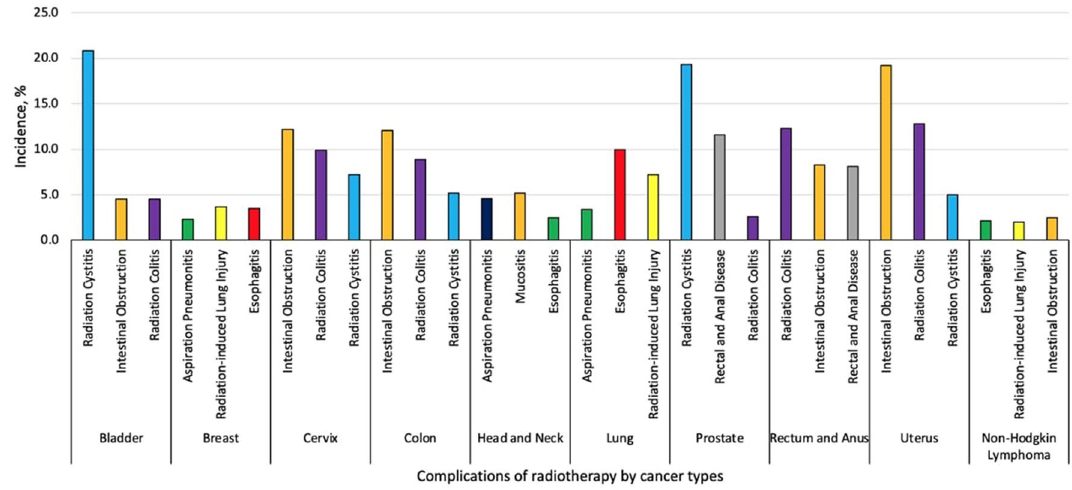
Figure 1. Percentage of patients admitted for RT related complications by most common cancer